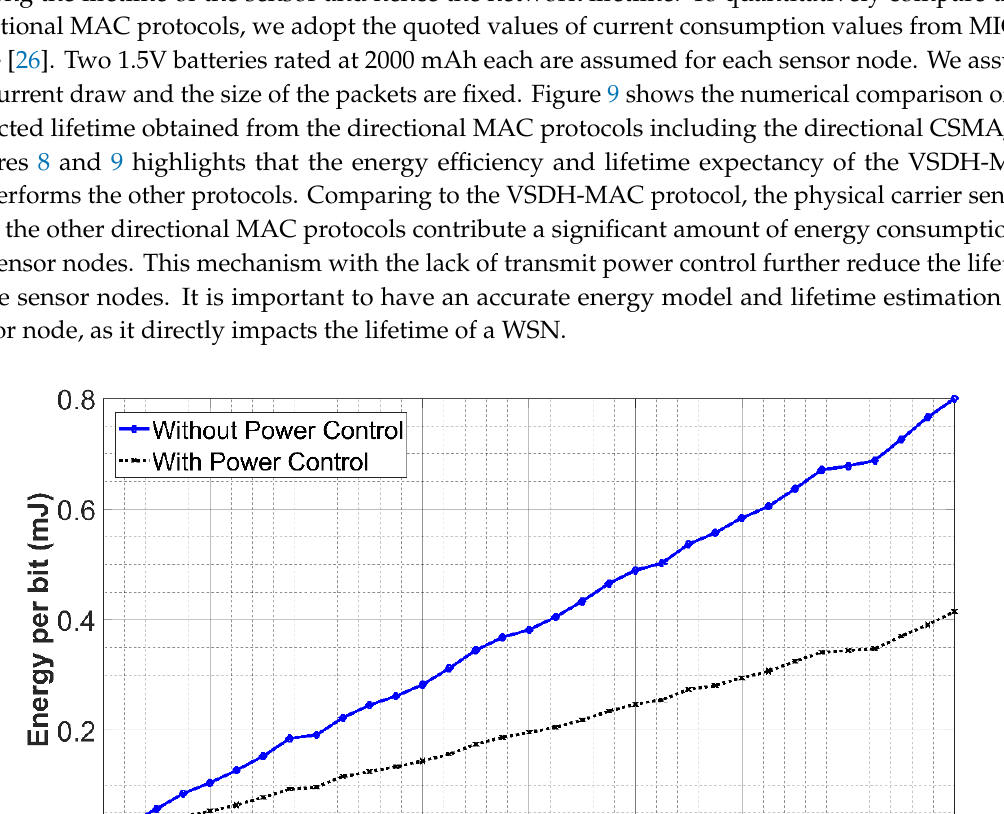
Figure 9. Comparison of expected sensor node lifetime with different network traffic load.